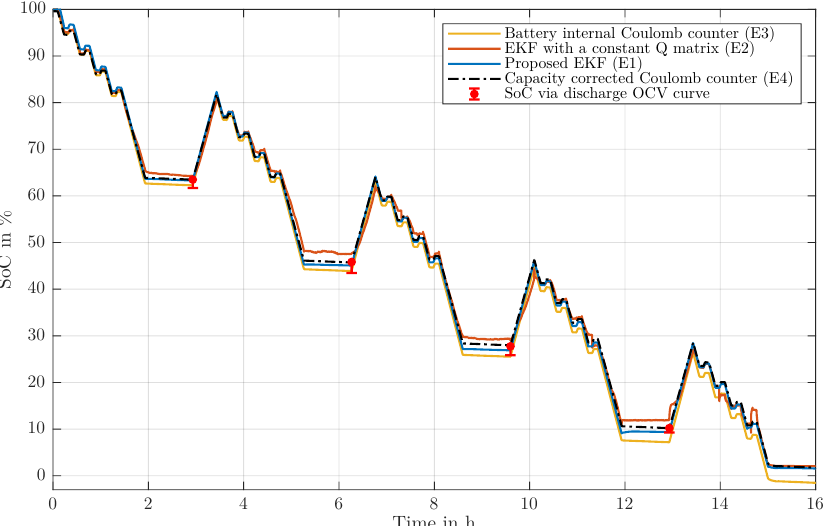
Figure 8. Measured cell voltage and current during the experiment. In the voltage diagram, the OCV capture points are marked. The current is the signal as measured by the imprecise internal current sensor, which is the same signal used in the EKF algorithm.